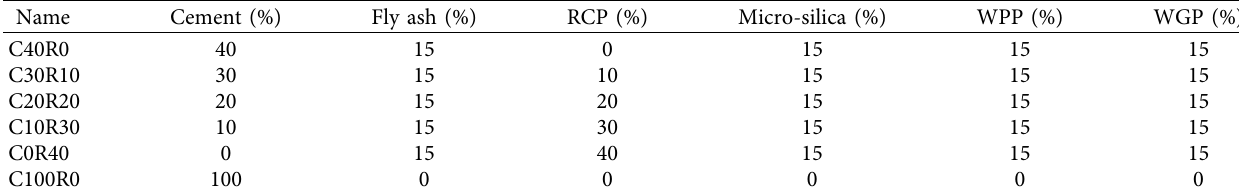
Table 9: Specimens’ specification.